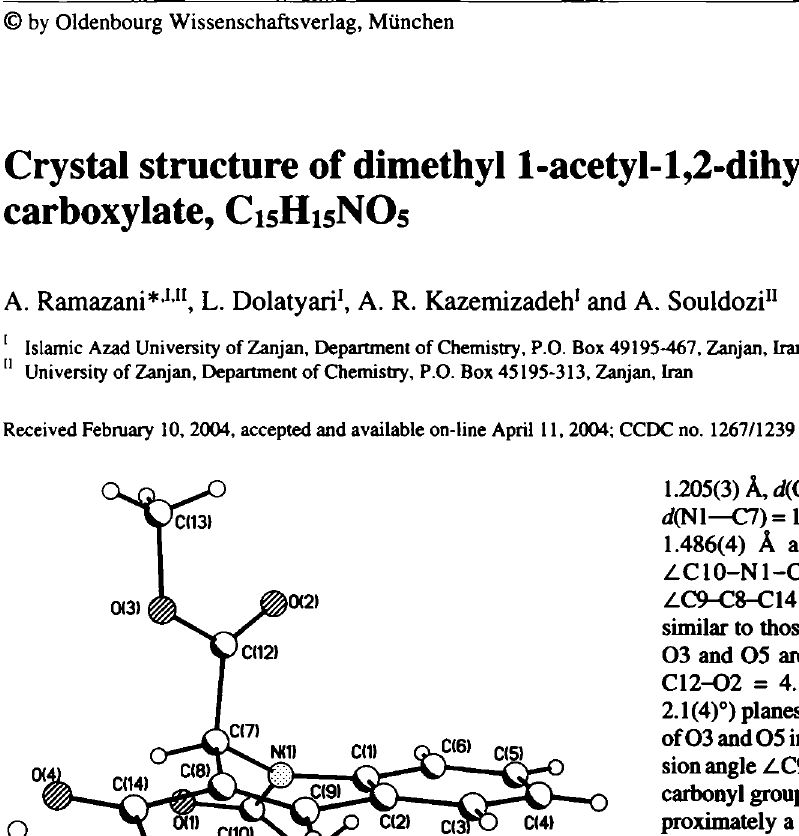
Table 1. Data collection and handling.